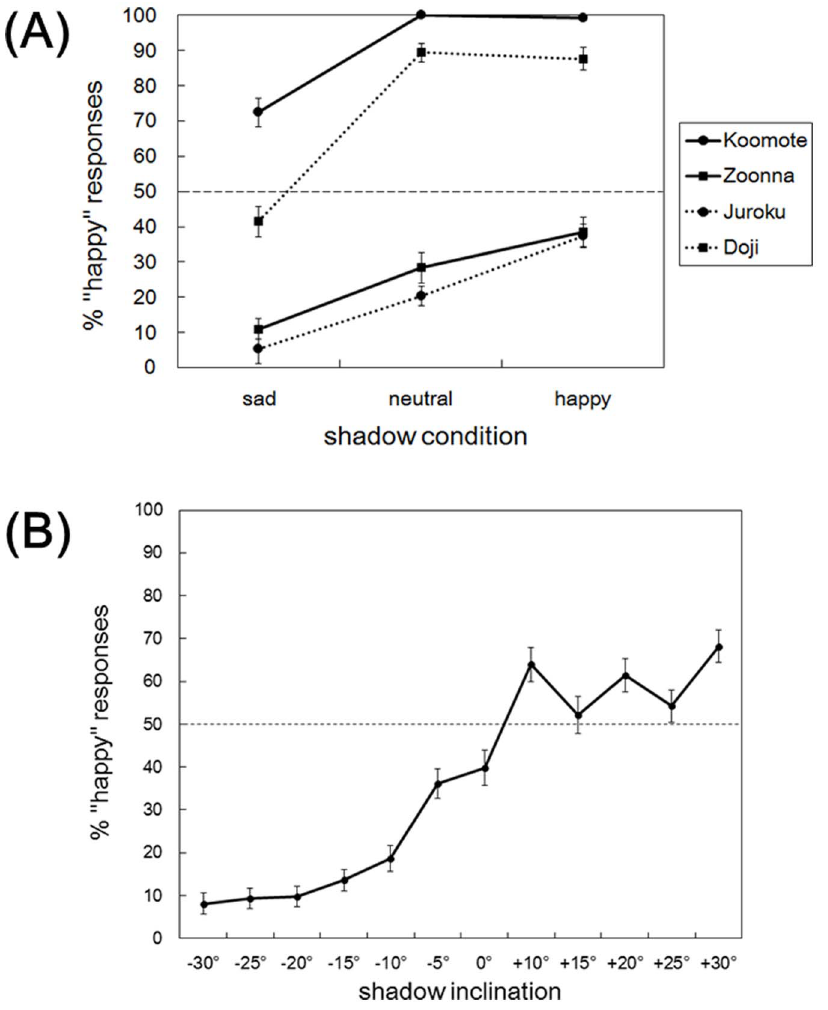
Figure 2. Results. ( A ) Proportion of the ‘‘happy’’ evaluation for each Noh mask type (i.e., Koomote, Zoonna, Juroku, and Doji) and shadow condition (i.e., sad, neutral, and happy) in Experiment 1. ( B ) Proportion of the ‘‘happy’’ evaluation for each shadow inclination in Experiment 2. The dashed horizontal lines indicate the chance proportion of the ‘‘happy’’ responses (50%). Error bars indicate standard errors of the mean.